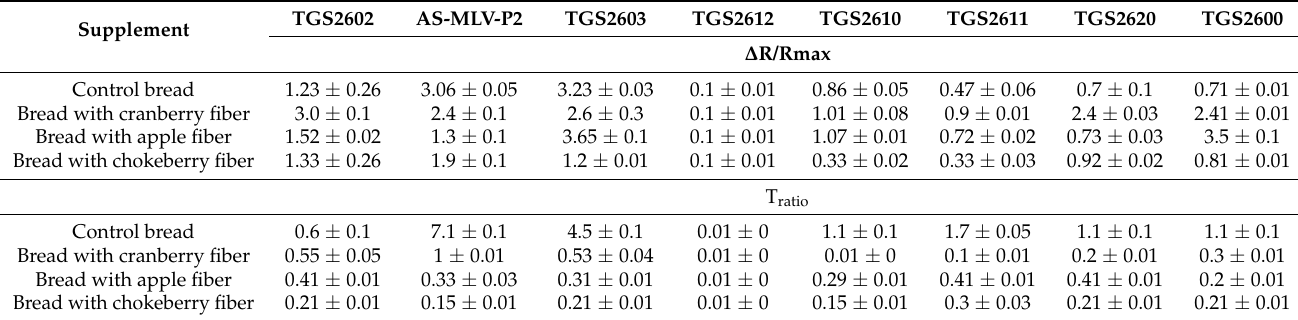
Table 2. Mean values of ∆ R/Rmax and Tratio with standard